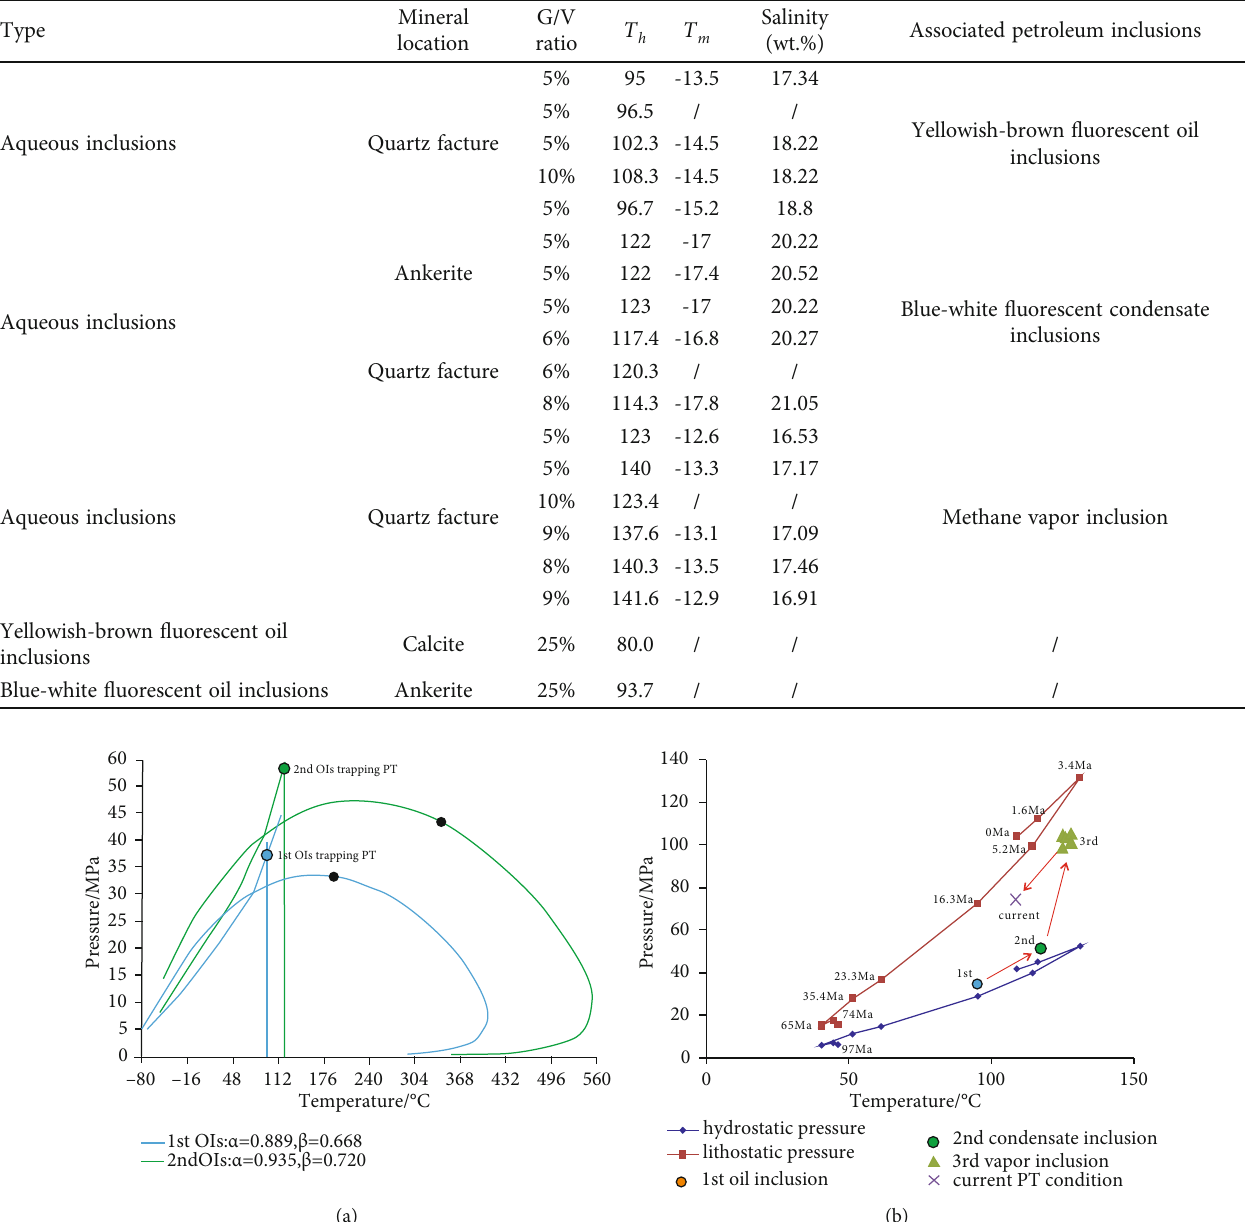
Table 1: Summary of results of fl uid inclusion microthermometry.